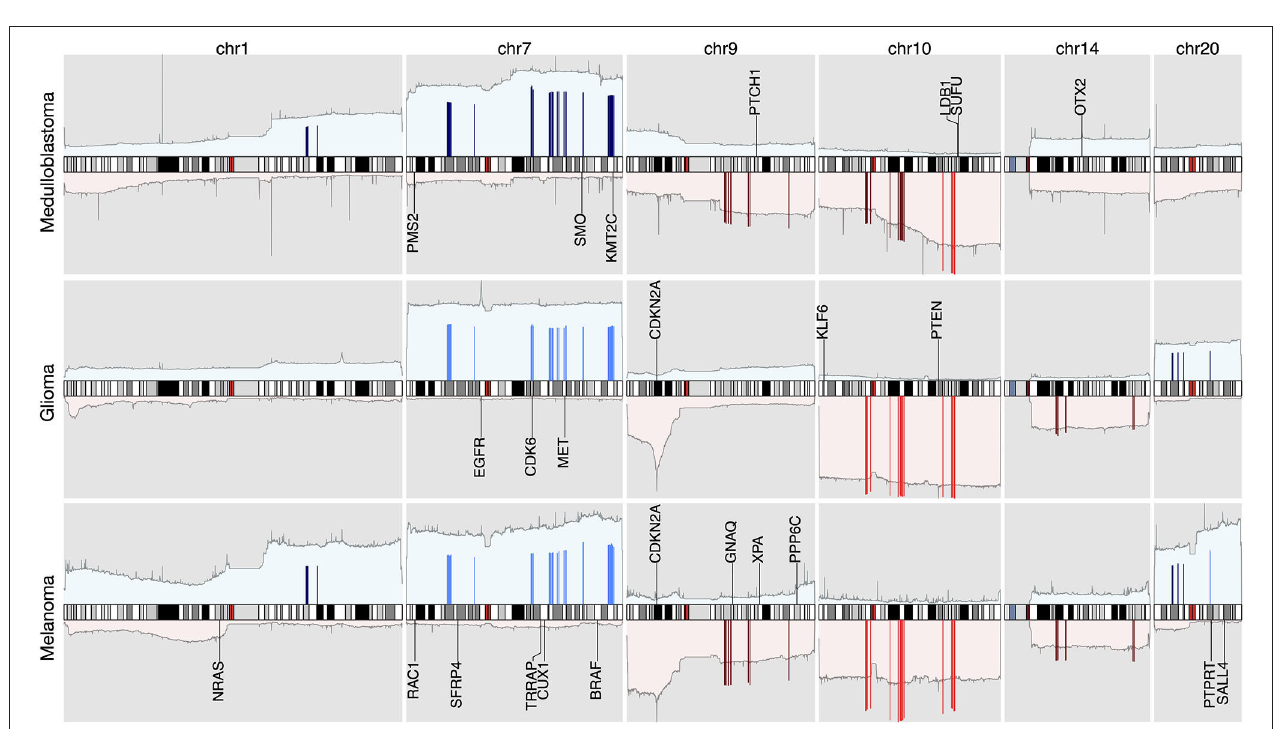
FIGURE 6 | The integrated view of the original data and the selected features, in the neural crest originating entities medulloblastoma, glioma, and melanoma. The shaded background area color illustrates the original data. Color bars illustrate the feature genes, where brighter colors indicate stronger signal intensity. The blue colors above the chromosome axis represent the average amplifications, and the red colors below the chromosome axis represent the average deletions. The amplitude of amplifications and deletions are normalized to [0,1] separately. The adjacent known driver genes are also included for each tumor type.